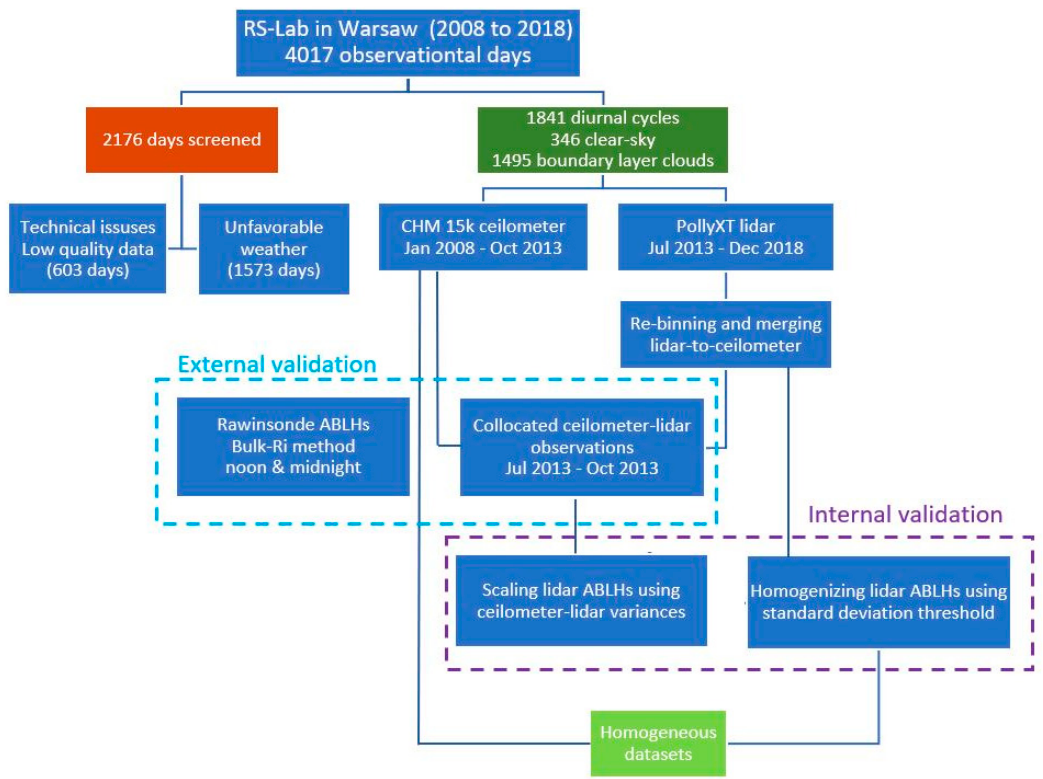
Figure 7. The ABLH data evaluation workflow allowing for the derivation of homogenized datasets from the PollyXT lidar and the CHM15k ceilometer observations in Warsaw.